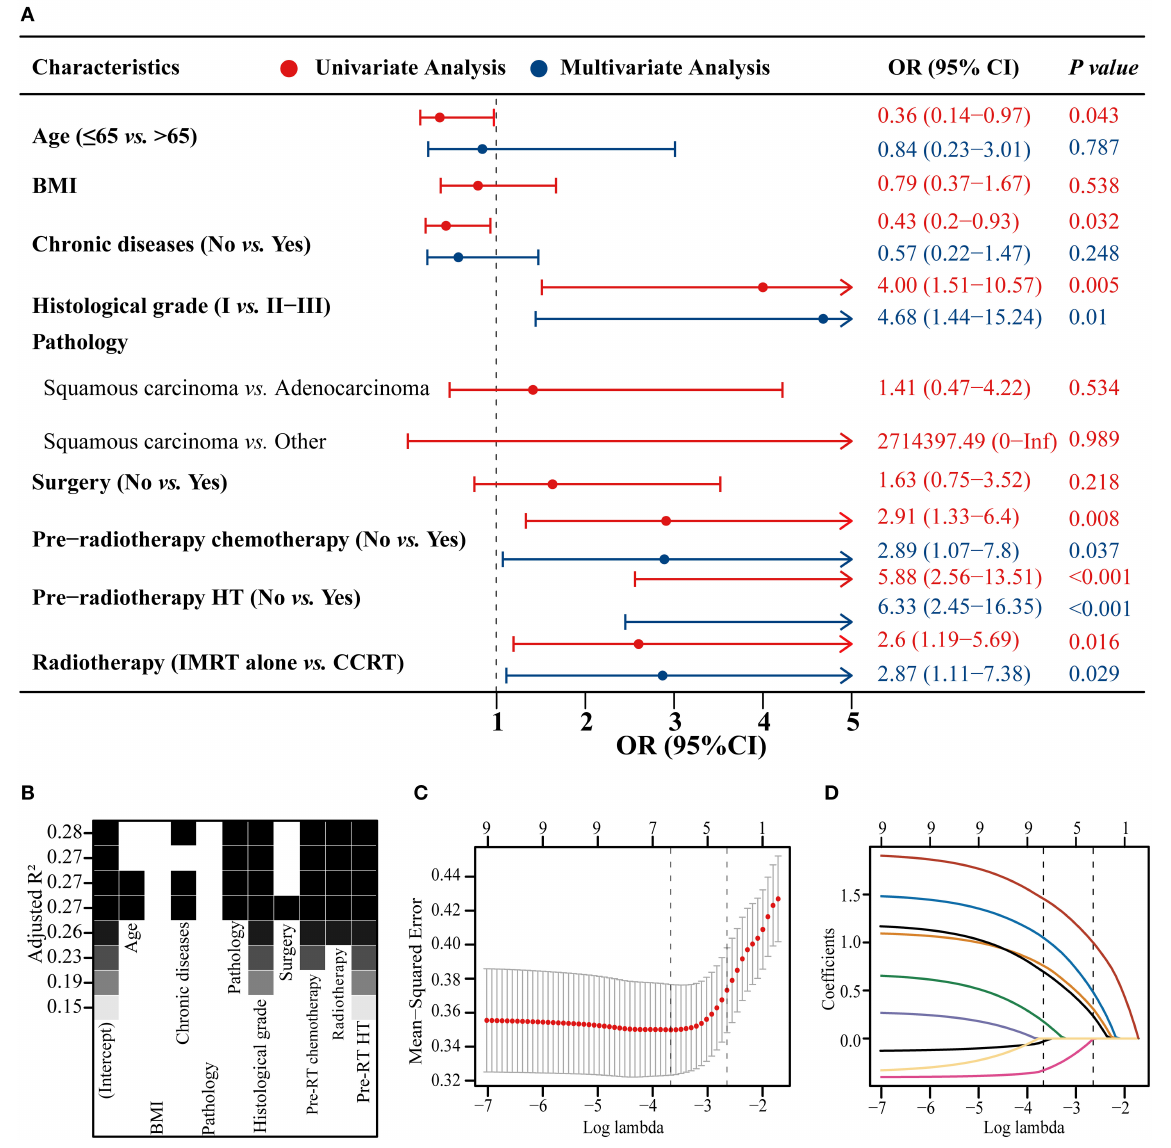
FIGURE1 Three methods of screening predictors. Univariate and multivariate logistic regression forest plot (A) , best subset regression (BSR) (B) , and least absolute shrinkage and selection operator (LASSO) regression plus 10-fold cross-validation (C,D) . BMI, body mass index; HT, hematological toxicity; IMRT, intensity modulated radiation therapy; CCRT, concurrent chemoradiotherapy; OR, odds ratio; CI, confidence interval.